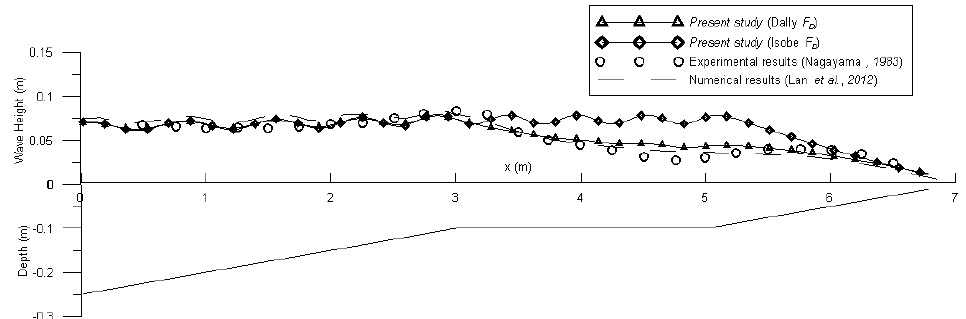
Figure 17. Wave heights for breaking and dissipation of waves by composite slopes of 1/20 with varying formulas of energy dissipation factors [25,27,30,45].